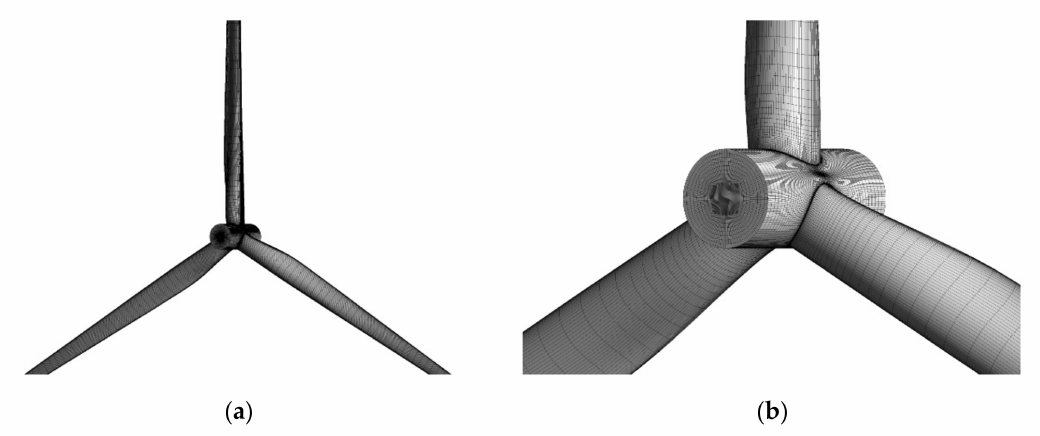
Figure 3. Computational mesh; ( a ) rotor; ( b ) blade surface.